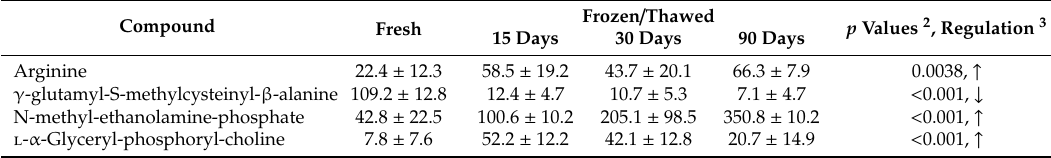
Table 3. The main down- and up-regulated metabolites identified as proposed markers for fresh and frozen discrimination in the bullet tuna sample (mean ± SD; µ g / g SI equivalents 1